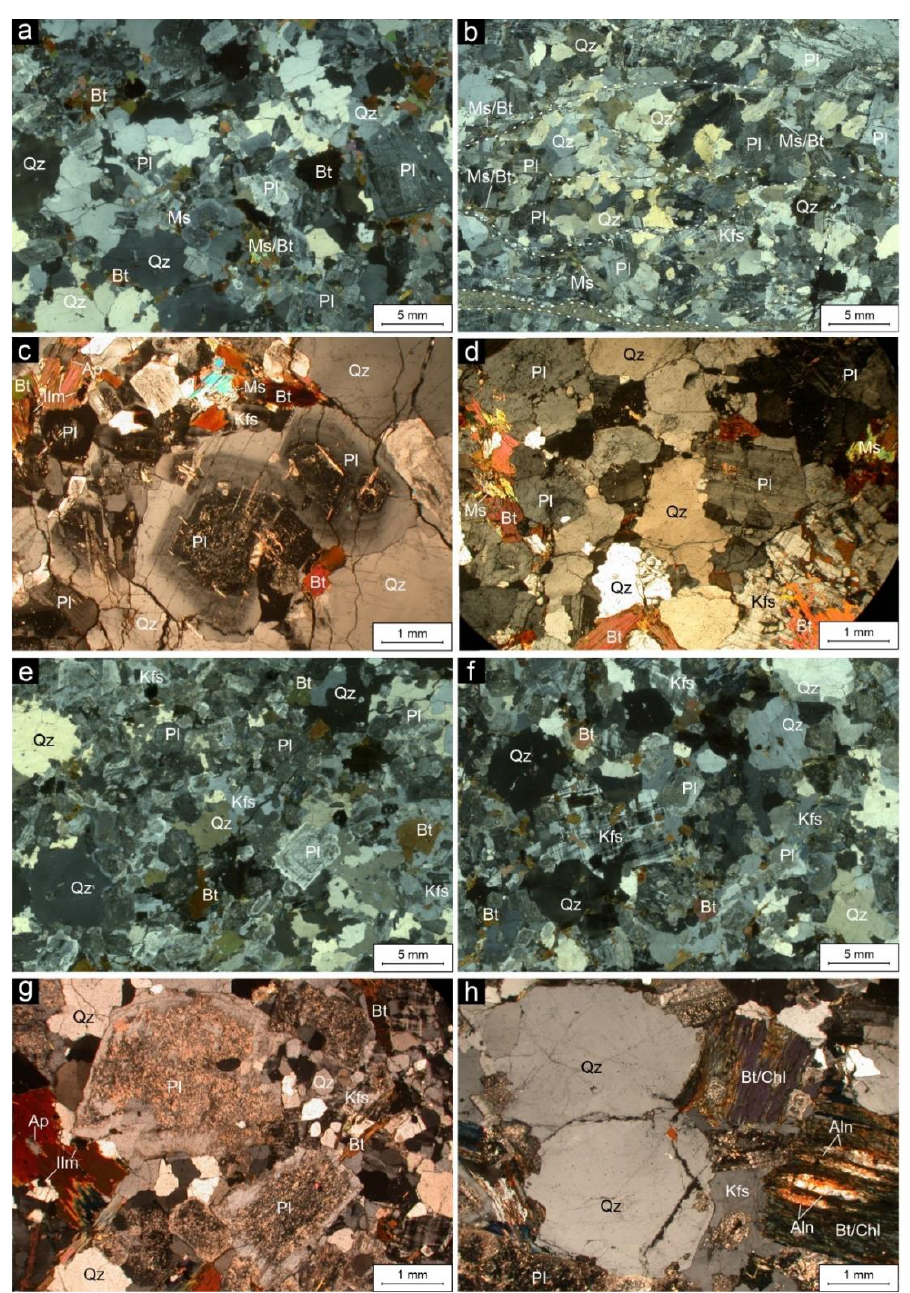
Figure 3. General petrographic features of the studied granitoids (crossed polars). Two-mica granites (MBG, a – d ): ( a , b ) thin-section scans showing subhypidiomorphic-autoallotriomorfic microstructures with pervasive fracturing in the sample on the right highlighted by dashed white lines (a: NDP10-N 38°27 ’ 43 ’’ , E 16°21 ’ 02 ’’ ; b: NDP5 – N 38°30 ’ 32 ’’ , E 16°21 ’ 19 ’’ ); ( c ) zoned plagioclase crystals, subhedral quartz crystals and aggregates of biotite/muscovite exhibit an inequigranular microstructure (NDP10); ( d ) euhedral plagioclase together with rounded quartz grains with lobated boundaries, microcline and interstitial lamellae of biotite (SO12-N 38°28 ’ 02 ’’ , E 16°16 ’ 27 ’’ ). Biotite ± amphibole granodiorites (BAG, e – h ): ( e , f ) thin-section scans showing slightly inequigranular hypidiomorphic microstructures (e: SO8-N 38°26 ’ 18 ’’ , E 16°14 ’ 23 ’’ ; f: NDP18-N 38°26 ’ 42 ’’ , E 16°20 ’ 28 ’’ ); ( g ) typical subhedral plagioclase crystals with sericitic core and unaltered rims in contact with biotite and poikilitic microcline (NDP17-N 38°26 ’ 09 ’’ , E 16°20 ’ 20 ’’ ); ( h ) subhedral fractured quartz crystals, altered plagioclase grains and partially chloritized biotite sheets with characteristic metamict allanite inclusions (NDP16-N 38°25 ’ 56 ’’ , E 16°20 ’ 45 ’’ ). Abbreviations are after Whitney and Evans (2010).